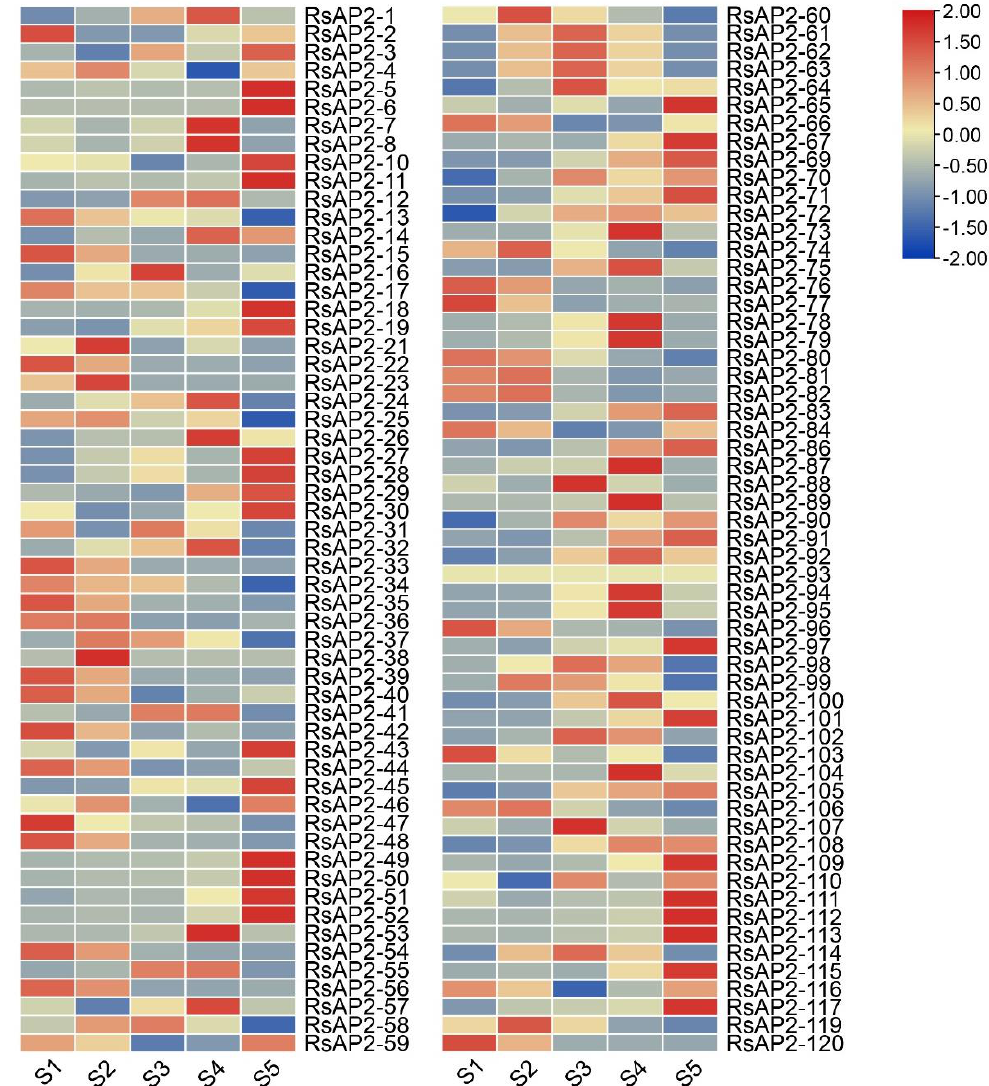
Figure 7. Heatmap of expression levels of RsAP2 genes in different development stages of Rhododen- dron flowers. The FPKM levels are transformed by log2 and labels of S1, S2, S3, S4 and S5 represent closed buds, buds showing color at the top but with the scales still present, initial flowering stage, full flowering stage and last flowering stage, respectively.